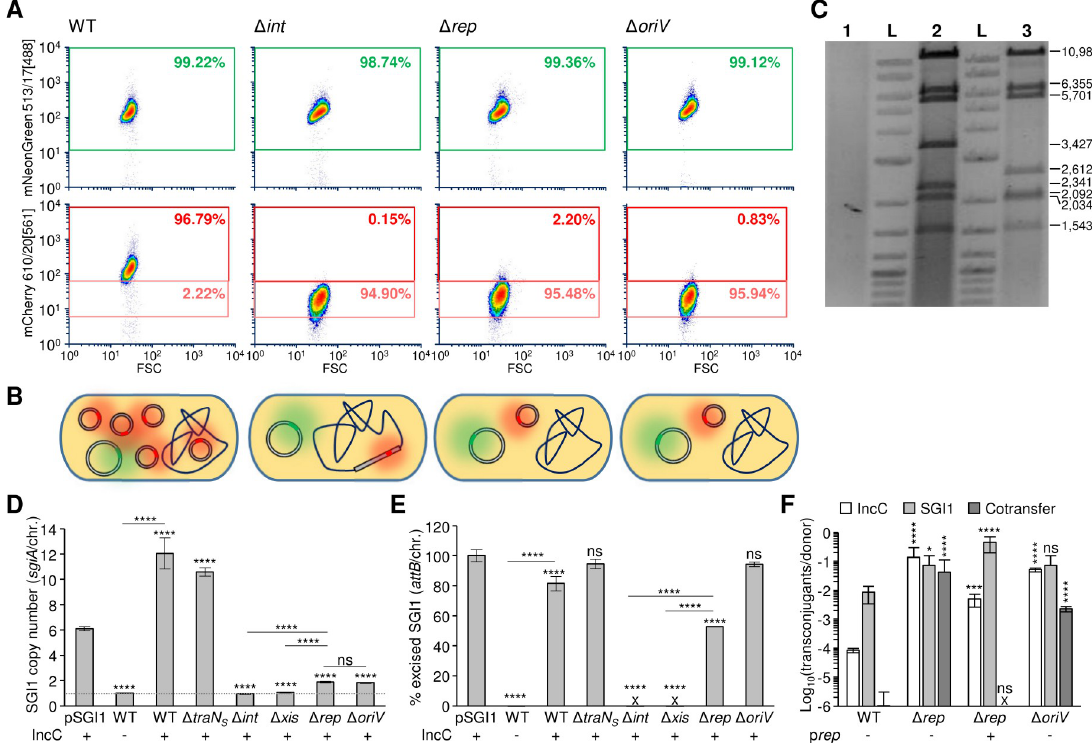
Fig 3. Replication of SGI1 in the presence of an IncC plasmid. A. Representative FC density plots of green and red fluorescence at G0 of cells bearing pVCR94 Green (IncC) and SGI1 Red (WT), its locked-in Δ int mutant and its Δ rep and Δ oriV mutants. B. Schematic representation of the cell content in the different mutants of panel A. C. Ethidium bromide-stained 0.8% agarose gel electrophoresis of EcoRI-digested plasmid DNA preparation of the same IncC + cells bearing SGI1 Red , its locked-in Δ int mutant or locked-out Δ int mutant (pSGI1). Lane 1, locked-in trmE ::(SGI1 Red Δ int :: aph ); Lane 2, SGI1 Red ; Lane 3, pSGI1; Lane L, 2-Log DNA ladder. D. Effect of deletions on SGI1 copy number. Quantification by qPCR of the SGI1 copy number as measured by the sgiA /chromosome ratios at G0. E. Effect of deletions on SGI1 excision. Quantification by qPCR of the percentage of cells at G0 that contain excised SGI1 as a measure of unoccupied attB sites per 100 chromosomes. “x” indicates that excision was below the limit of detection ( < 10 − 5 %). Assays were carried out in E . coli KH95 carrying (+) or lacking (-) the helper IncC plasmid pVCR94 Green or pVCR94 GreenSp (for pSGI1 only). The bars represent the mean and standard error of the mean obtained from at least three independent experiments. Statistical analyses were carried out on the values using the one-way ANOVA with Tukey’s multiple comparison test. F. Effect of SGI1 replication on conjugative transfer of SGI1 and its helper plasmid. Conjugation assays were carried out using E . coli KH95 as the donor and E . coli VB113 as the recipient. When indicated (+), Rep was provided in trans from p rep . Transfer frequencies are expressed as the number of transconjugant per donor CFUs. Statistical analyses were carried out on the logarithm of the values using the one-way ANOVA with Sidak’s post-test to compare each mutant set relatively to SGI1 Red (WT) control. The bars represent the mean and standard deviation values obtained from at least three independent experiments. Statistical significance is indicated as follow: ���� , P < 0.0001; ��� , P < 0.001; � , P < 0.05; ns, not